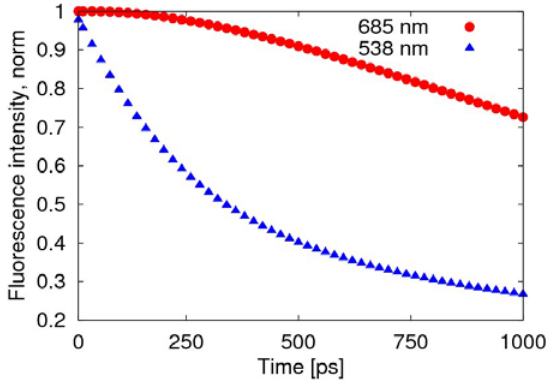
Figure 5. Time evolution of the fluorescence spectra after normalization. The red round points (685 nm) represent light emitted by the transformation of the triplet exciton, while the blue triangular points (538 nm) represent the light emitted by the decay of the singlet exciton.